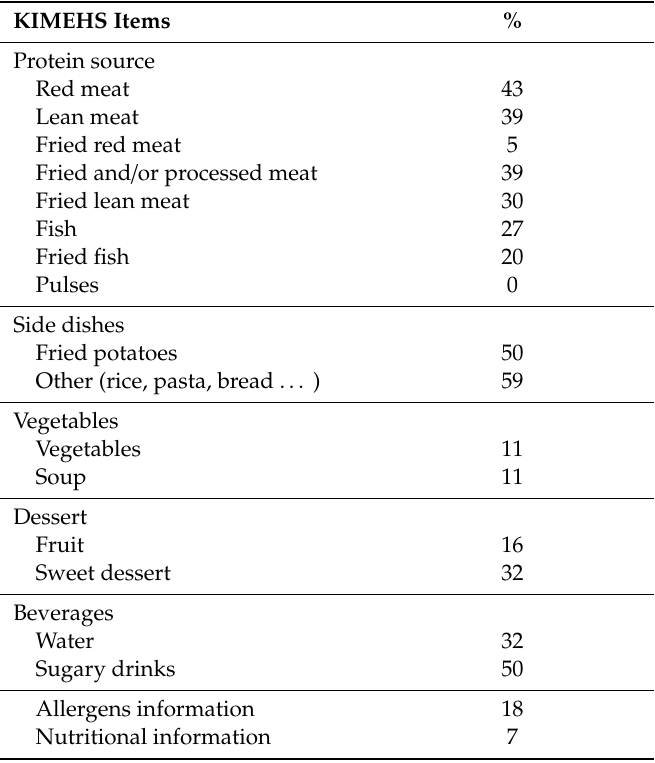
Table 3. Availability (%) of KIMEHS components in evaluated